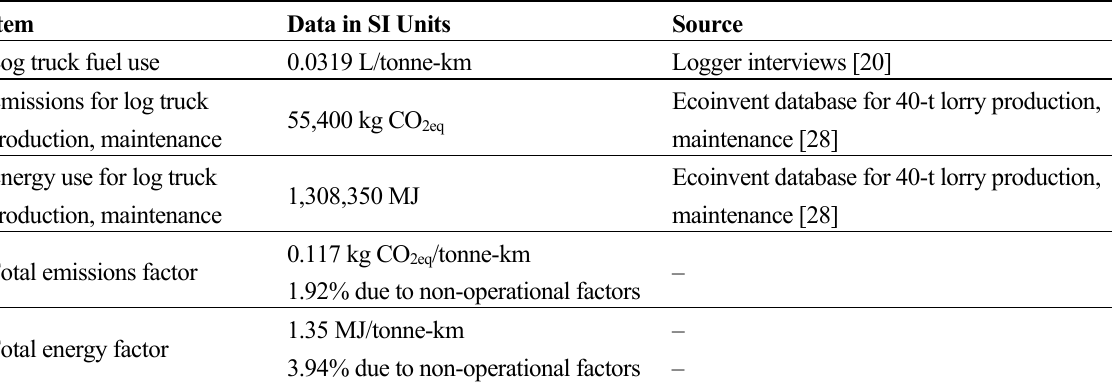
Table 4. Data and assumptions for truck transportation.